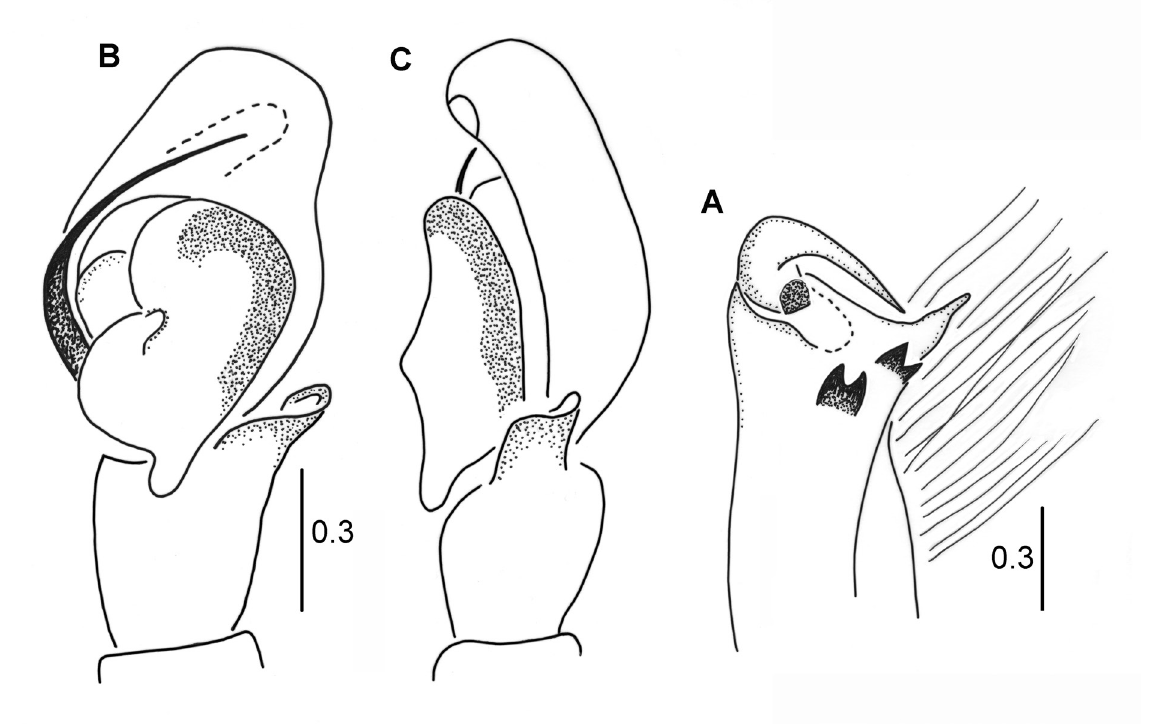
Fig. 74. Tusitala cornuta sp. nov., paratype, ♂ (MNHN). A . Chelicera, ventral view. B . Palpal organ, ventral view. C . Palpal organ, lateral